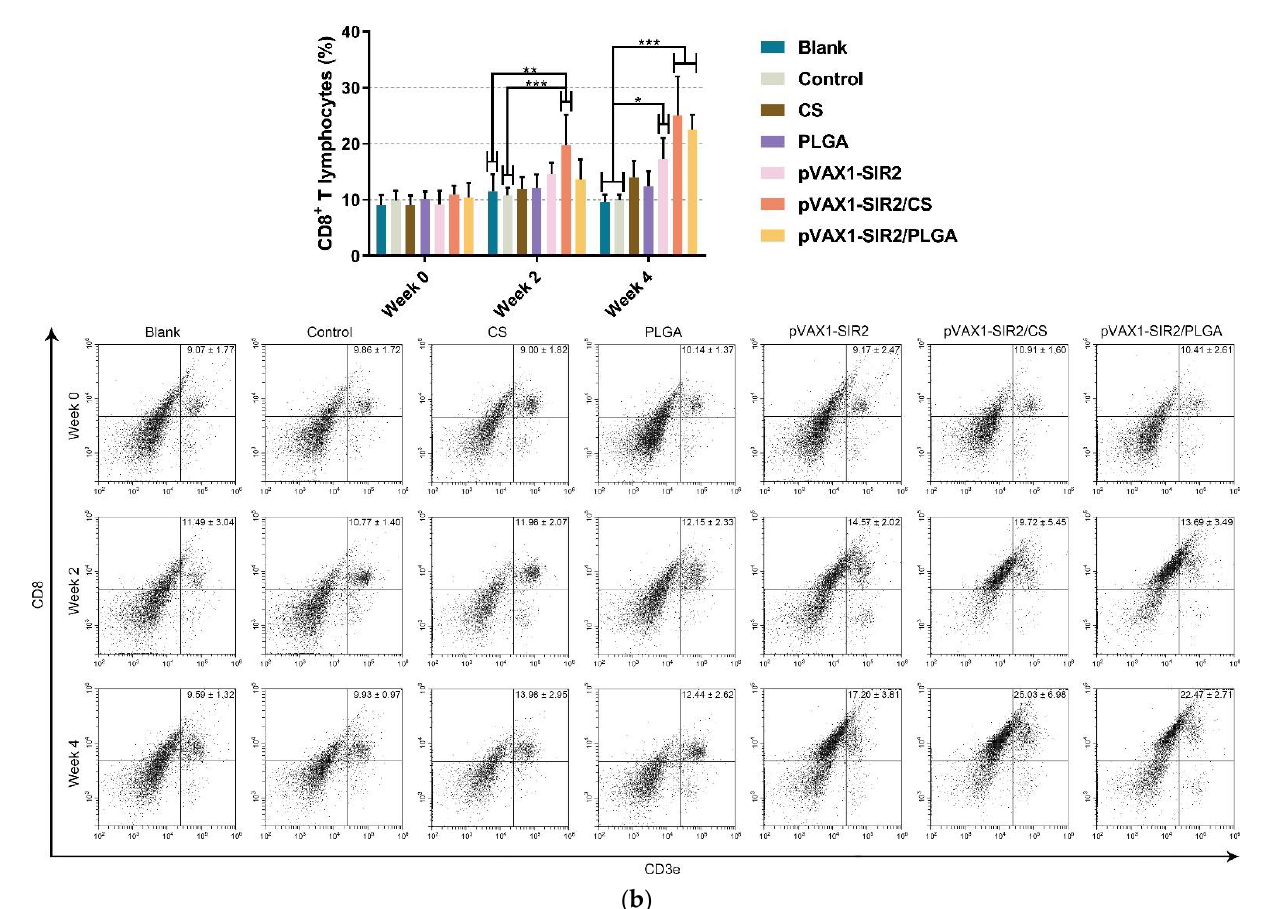
Figure 10. Proportions of CD4 + and CD8 + T lymphocytes at week zero, two, and four. Stained with CD3e-PE, CD4-FITC ( a ) or CD3e-PE, CD8-FITC ( b ), the separated lymphocytes were evaluated by flow cytometry. Each sample was investigated once, and values were analyzed by one-way ANOVA analysis followed by Dunnett ’ s test. Values between the pVAX1-SIR2/CS and pVAX1-SIR2/PLGA group were estimated by the independent t -test. Values were shown as mean ± SD (n = 5). * p < 0.05, ** p < 0.01, and *** p < 0.001 compared with blank or control group.